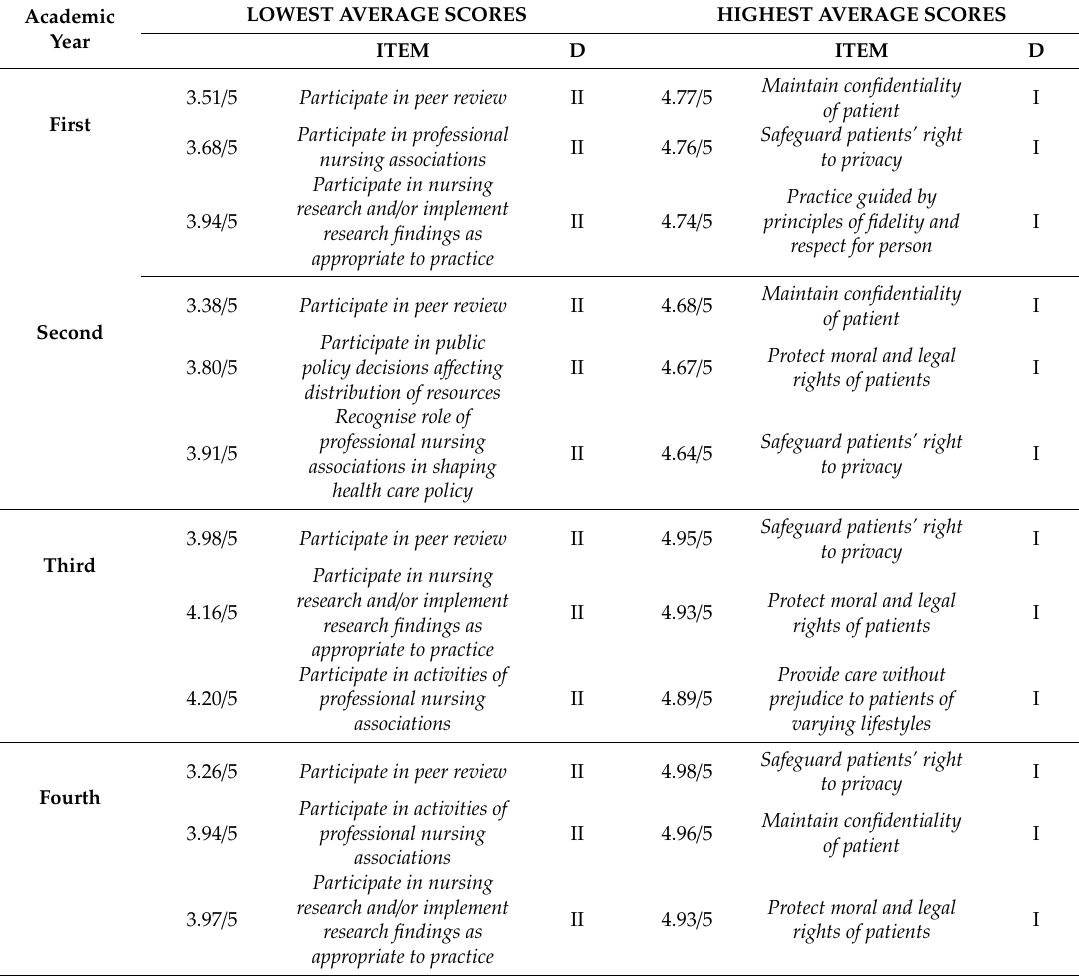
Table 4. Score comparison between the lowest and highest scores in relation to the academic year and